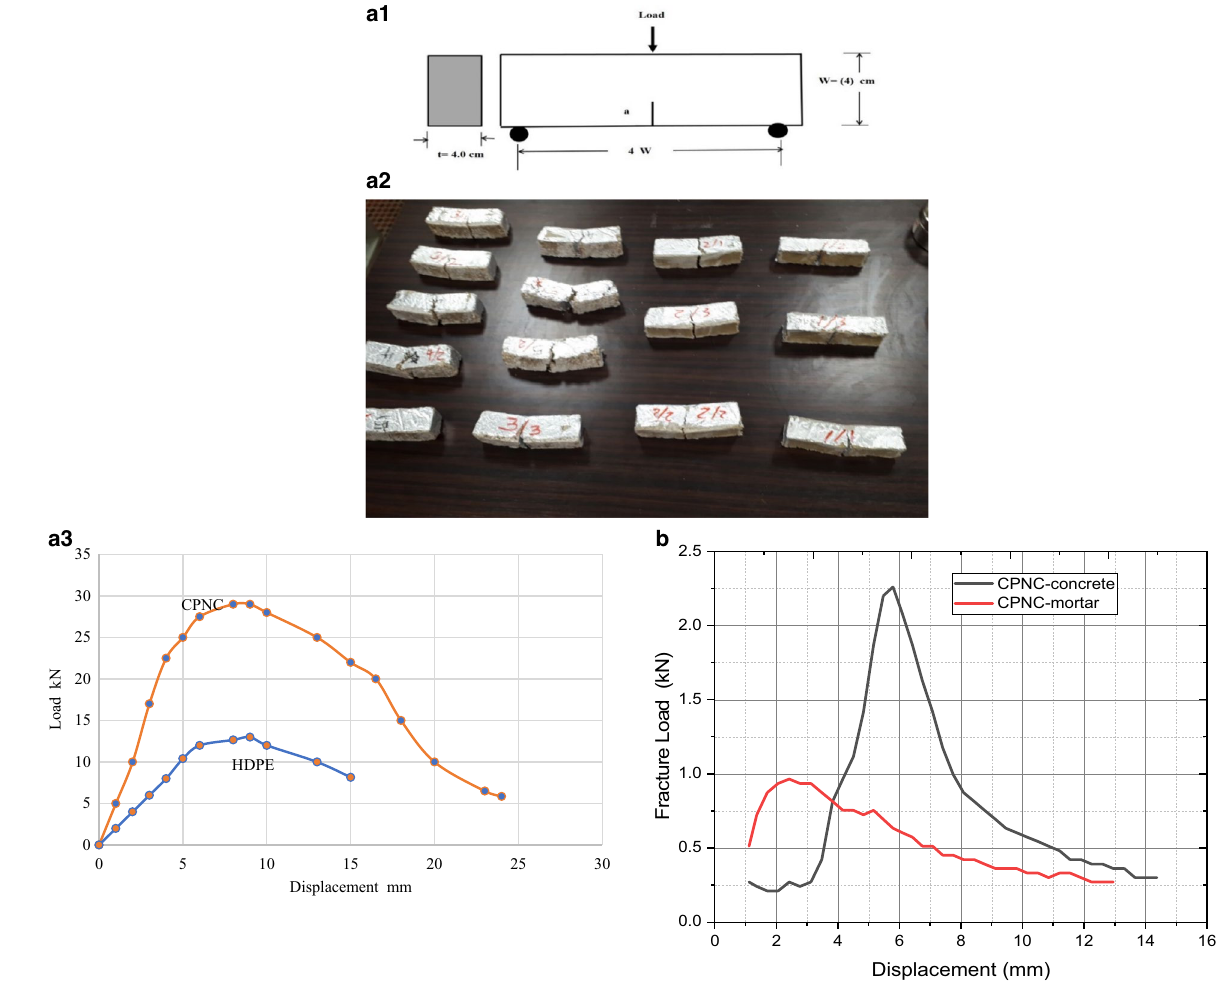
Figure 4. (a1) Standard model of SENB tested samples for fracture properties under 3-point loading, based on the ASTM standard. Some tested samples are shown in ( a2 ). ( a2) Tested samples of CPNC concrete for fracture properties, showing no separation at the cracked zone because there is no sudden failure or rapid crack propagation due to the ductile behaviour. ( a3) Load ‒ displacement relationship of pure HDPE (M40060) and CPNC (HDPE and MMT) under the SENB fracture properties test. ( b ) Load ‒ displacement curves of tested beams of CPNC concrete and mortar for fracture toughness (K Ic ) and fracture energy.